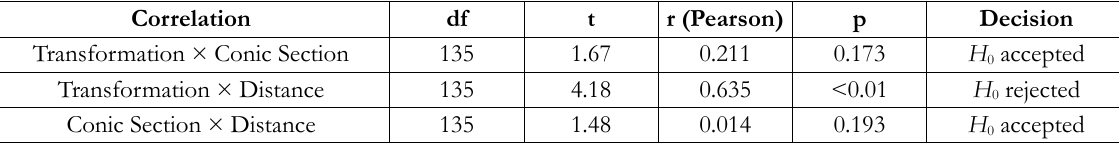
Table 4. Effectiveness of